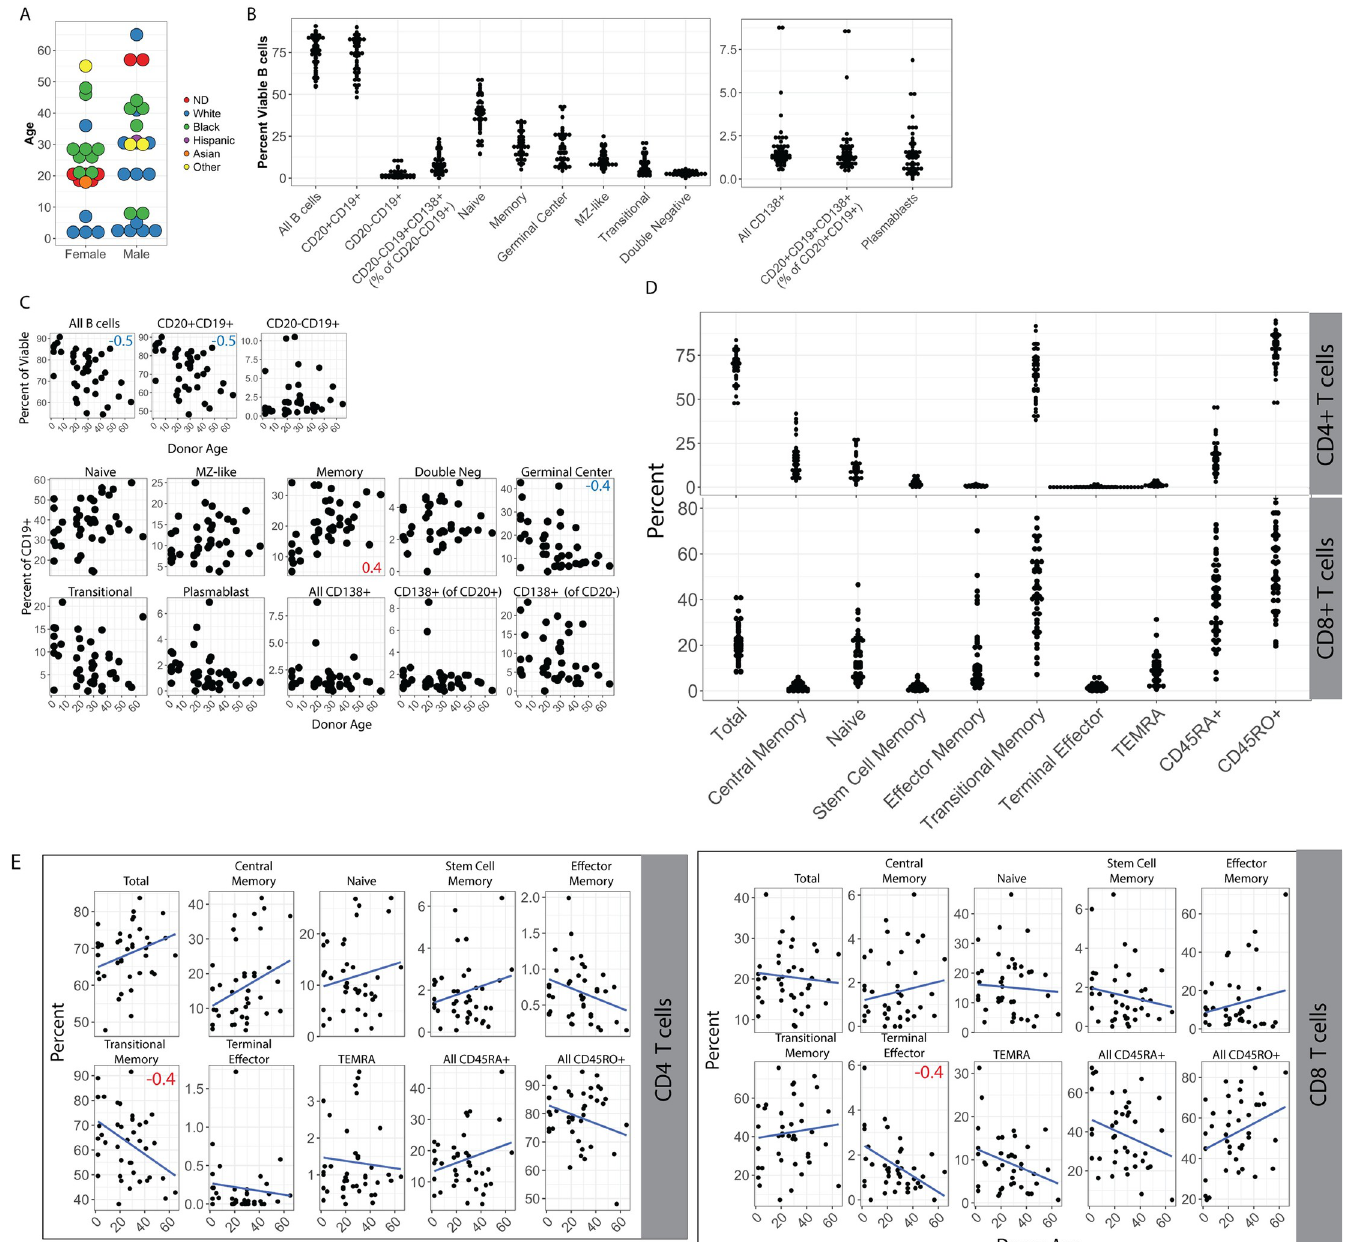
Fig 1. Variablility and age-dependence of B lymphocyte lineage distribution in human tonsils. (A) Donor demographics for human tonsil specimens used in this study. Plotted by age (y-axis), sex (x-axis) and self-reported race (color) ND = not determined. (B) Frequency distributions of B cell lineages in tonsil specimens (see S1A Fig and Table 2 for lineage definitions). All B cells are shown as frequency of viable lymphocytes, other B cell subsets are shown as frequency of viable, CD19+ B cells unless otherwise specified in parenthesis. (C) Frequency of B cell lineages based on donor age. Pearson correlation coefficients (r) with an absolute value greater than or equal to 0.4 are shown as red or blue inset text in the subset panels. (D) Frequency distributions of T cell lineages in tonsil specimens (see S1B Fig and Table 2 for lineage definitions). All T cells are shown as frequency of viable CD4+ (top) or CD8+ (bottom) T cell except total CD4+ and total CD8+ (far left) which are shown as frequency of viable lymphocytes. (E) Frequency of CD4+ (left) and CD8+ (right) T cell lineages based on donor age. Pearson correlation coefficients (r) with an absolute value greater than or equal to 0.4 are shown as red or blue inset text in the subset panels.